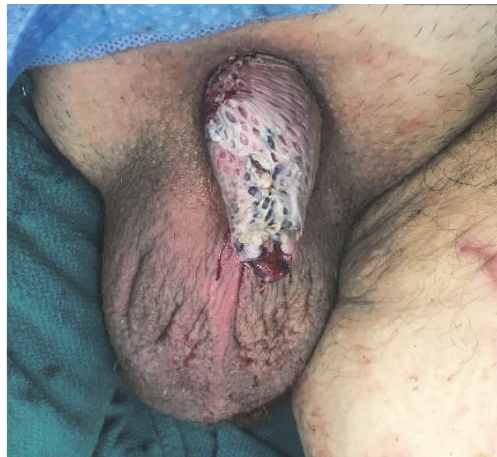
Figure 6: Dorsal shaft following placement of split thickness skin graft.